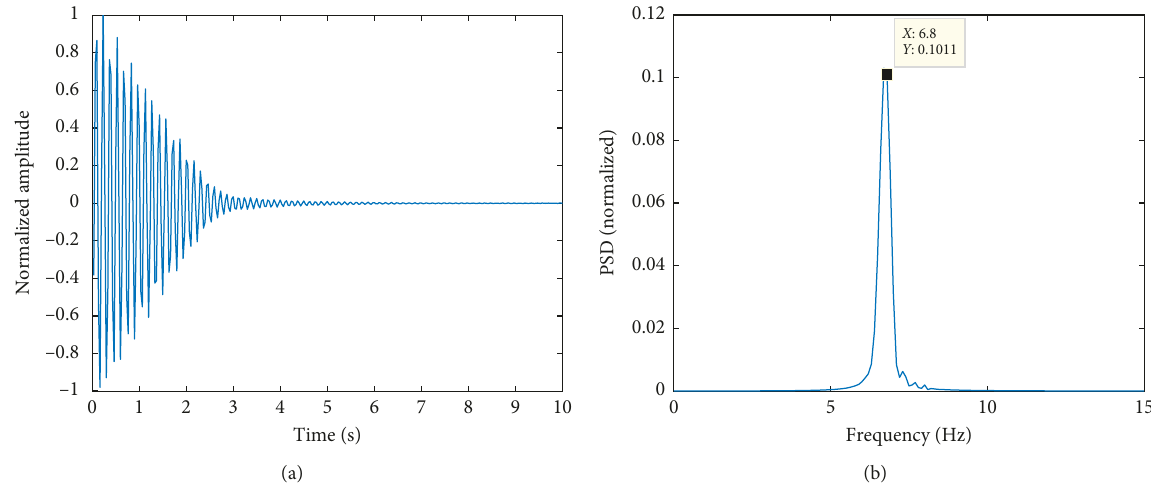
Figure 23: Simply supported carbon plate experimental case 1 result from the vibrometer. (a) Normalized acceleration signal. (b) Normalized power spectral density